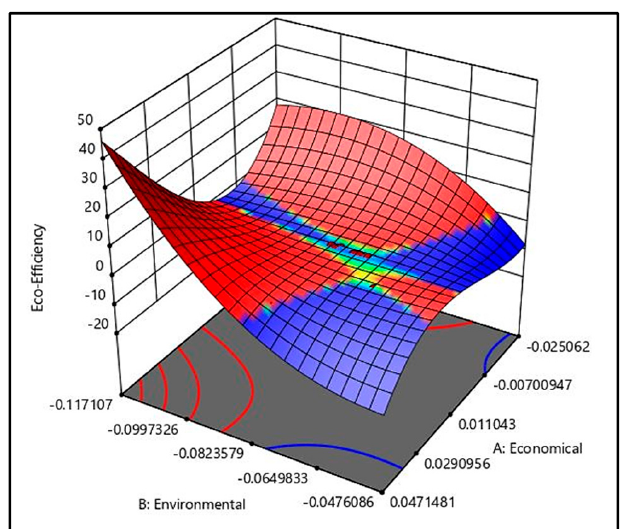
Figure 17. Response surface graph of fly ash based concrete used for double story houses.